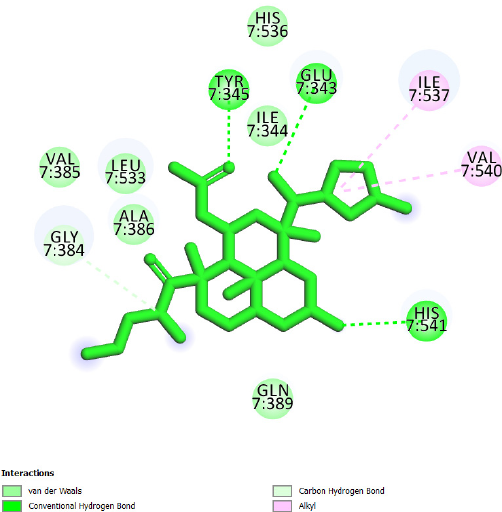
Figure 2. MCM7 protein-interacting residues with UEFS137. Different color codes represent the residual interaction types.